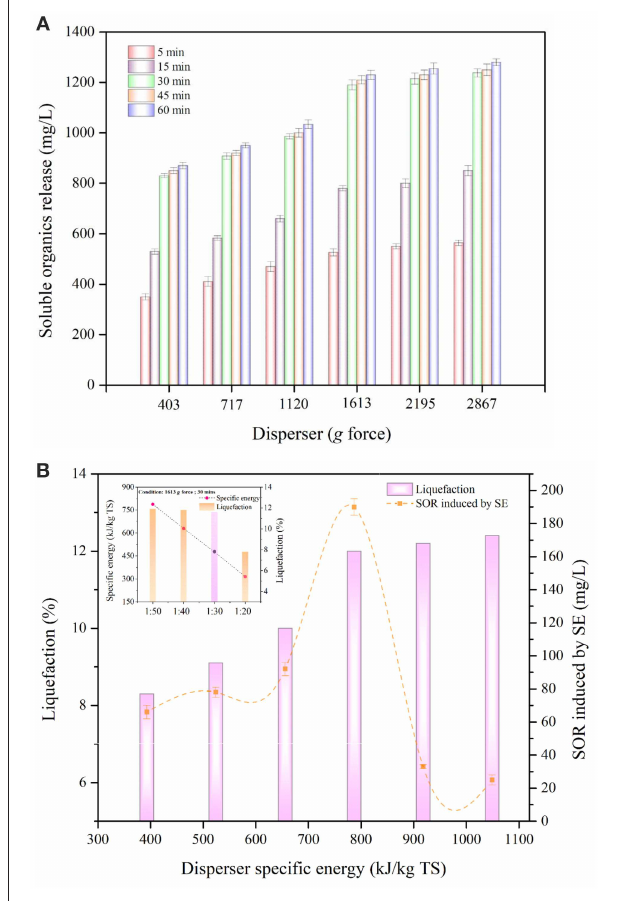
FIGURE 1 | (A) Effect of disperser G force on liquefaction of MAB. (B) Effect of disperser specific energy on liquefaction of MAB.